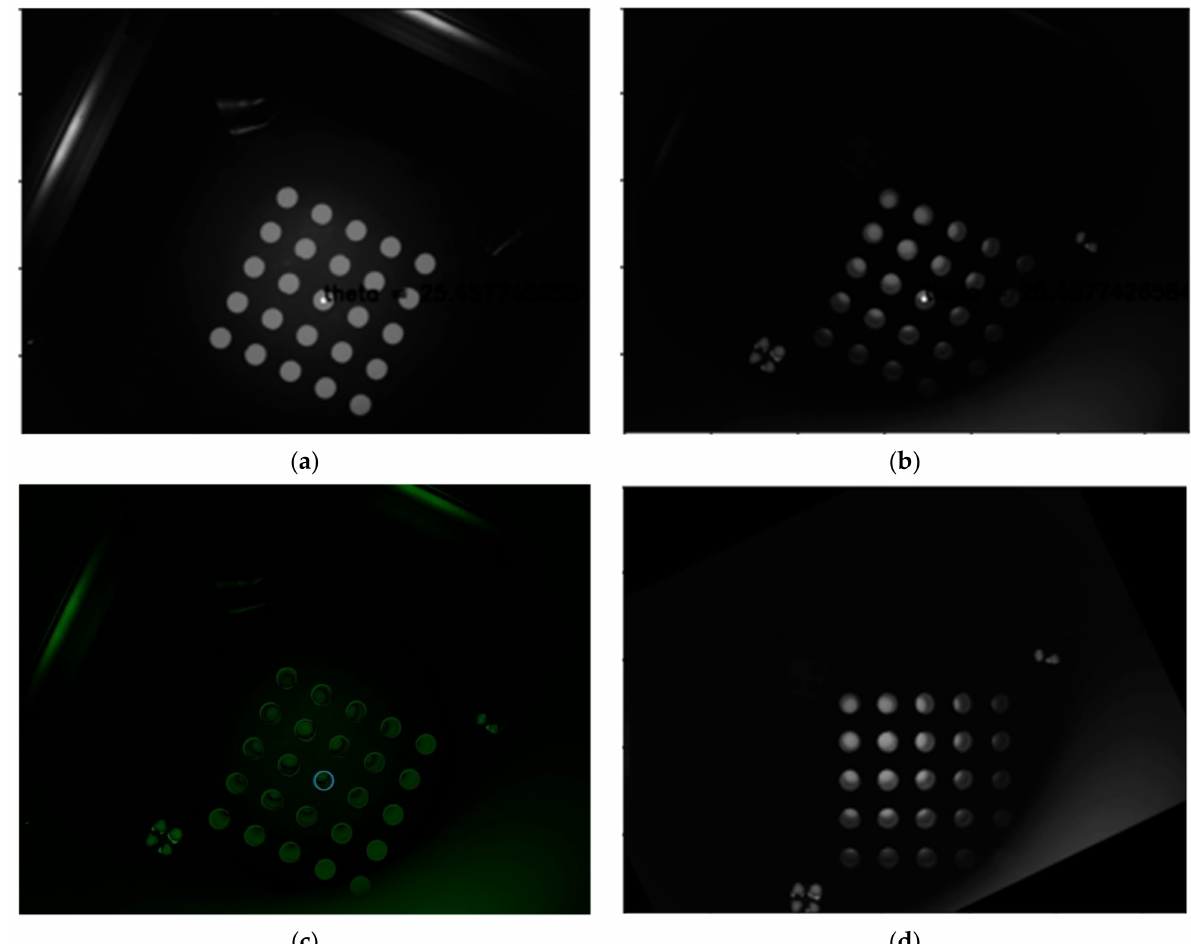
Figure 9a is a second quadrant image taken using a mask sheet, and Figure 9b is a second quadrant image taken of a tube containing a FAM reagent. Figure 9c illustrates the difference between the mask sheet and the fam solution by combining them. When the position of the diameter of the circle at the center of the 5 × 5 tube was marked, the distances between the tubes comprised fewer than 1.5 pixels. Therefore, it was found that there was no problem in using the image rotation center and rotation angle calculated by the mask sheet. Figure 9d shows the image rotated by the rotation center and rotation angle obtained with the mask sheet in the FAM image of (b). This image also showed that the calibration was stable.